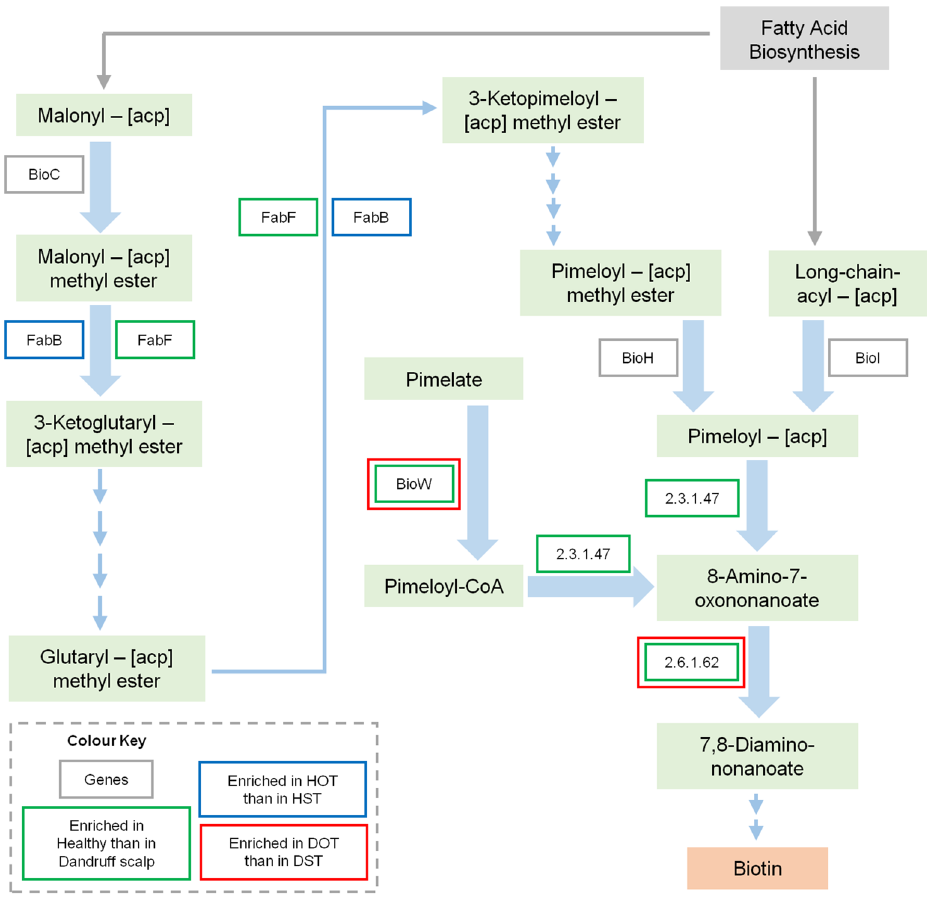
Figure 7. Schematic representation of biotin metabolism pathway describing the significantly enriched KOs ( p ≤ 0.05) in the